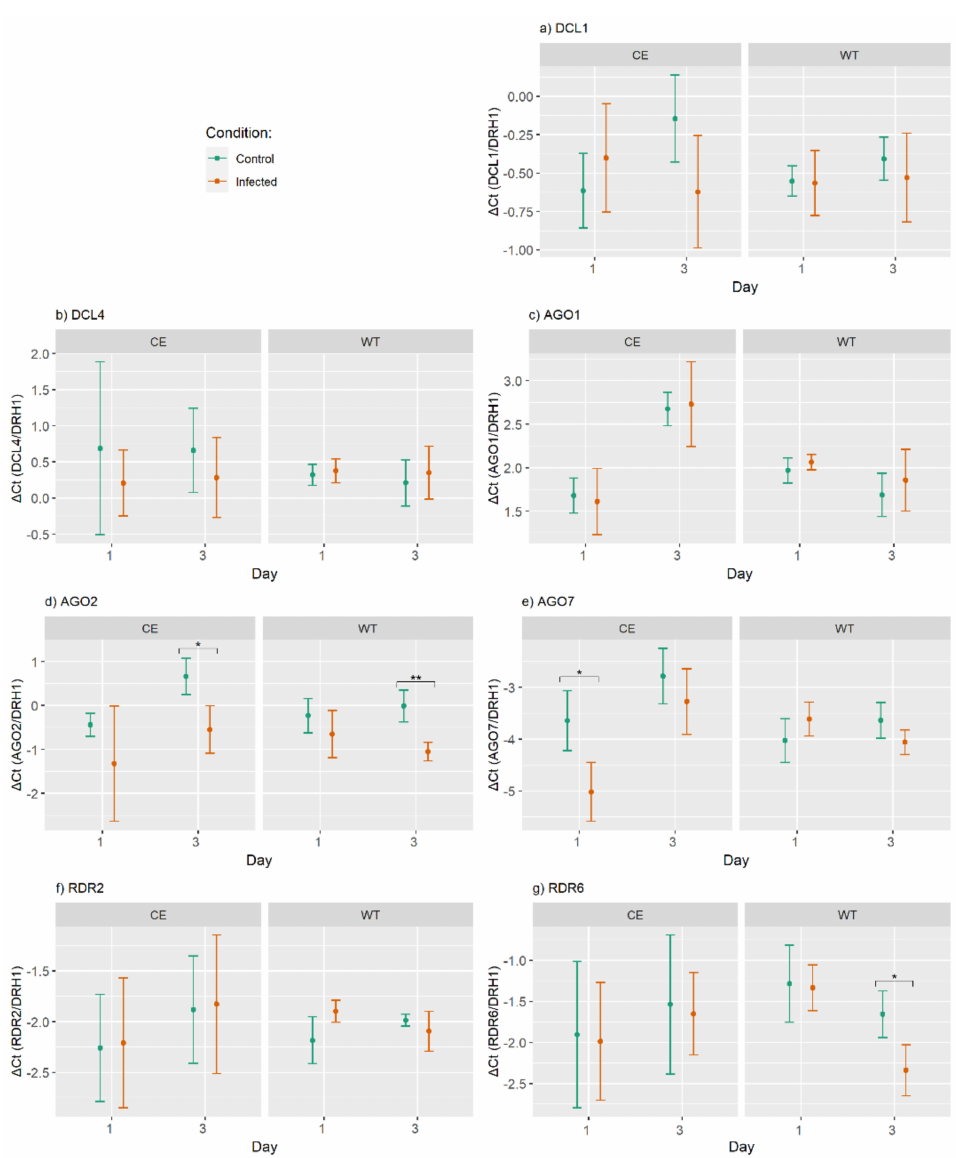
Figure 3. Expression levels of hop RNAi genes ( a – g ) in control and V. nonalfalfae -infected root tissue of the susceptible cultivar Celeia (CE) and the resistant cultivar Wye Target (WT) on the first and third day post-inoculation. The data are presented as mean ± standard deviation of the ∆ C t values. An asterisk “*” indicate significant differences between control and treated samples at a signifi-cance level FDR p -value ≤ 0.05, and “**” at FRD p -value ≤